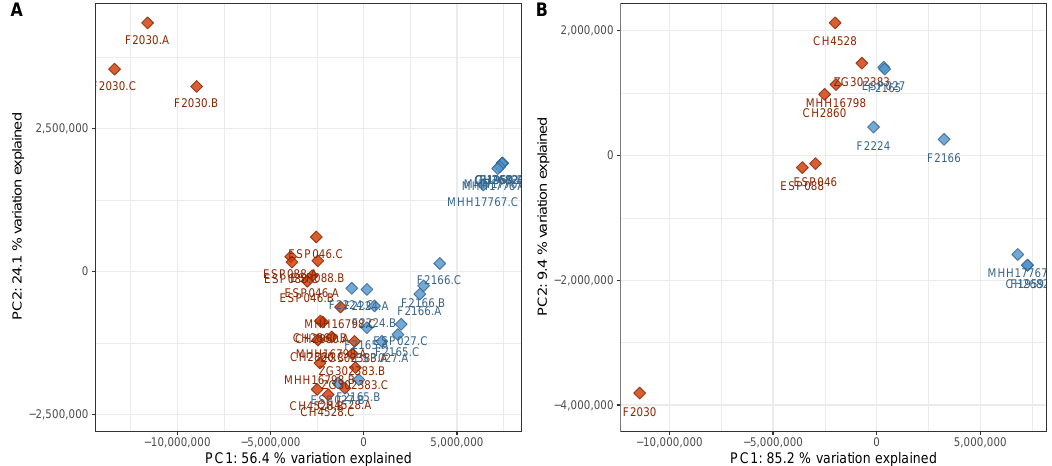
Figure 4. PCA scores plot of the discovery data set with only virulence-associated secondary metabolites included into the calculation. The plot has been created analogously to Figure 1 and shows a comparably good separation between the two phenotypes based on virulence-associated secondary metabolites only. ( A ) Data on sample level, ( B ) data on strain level (cf. Figure 1). Red—virulent cluster A strains, blue—avirulent cluster B